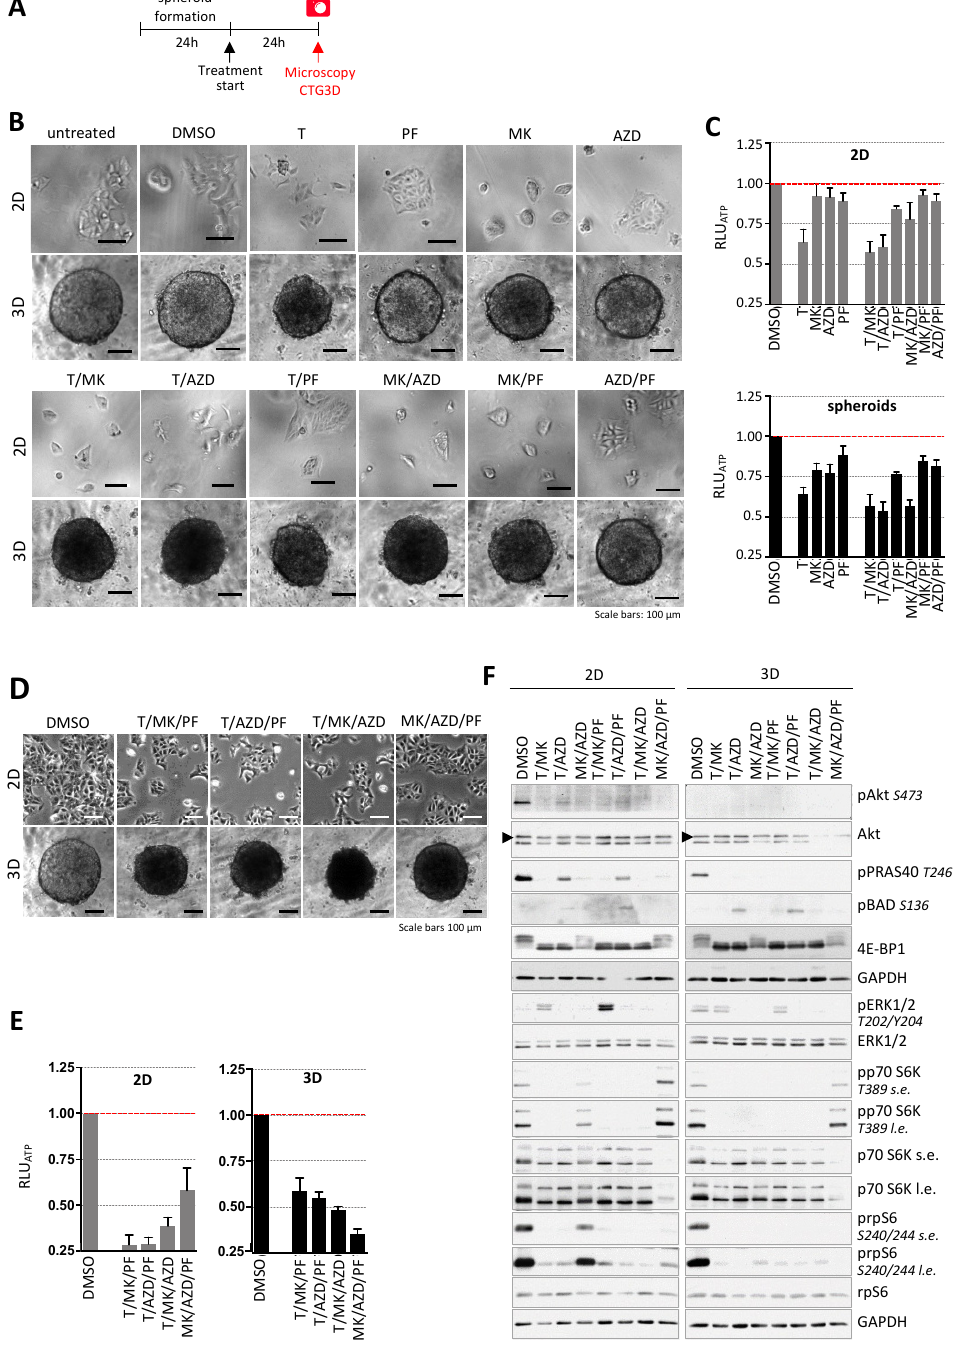
Figure 1. Effect of inhibitor combinations on DLD-1 cells. ( A ) Overview of the time frame of the experiment. ( B ) Representative phase contrast microscopic images of DLD-1 cells in 2D and 3D culture treated with single inhibitors and combinations of Torin1 (T, 250 nM), PF4708671 (PF, 10 µ M), MK2206 (MK, 1 µ M) and AZD6244 (AZD, 1 µ M) for 24 h. Untreated and DMSO cultures are controls. Scale bars represent 100 µ m. ( C ) Cellular ATP levels were determined with CellTiter-Glo 3D. Luminescence values (RLU ATP ) were normalized to the DMSO controls ( n = 6 per condition). Bar graphs are presented as mean ± standard deviation (SD). 2D in gray bars; spheroids in black bars. ( D ) Representative phase contrast microscopic images of DLD-1 cells in 2D and 3D culture upon inhibitor treatment (inhibitor concentrations as in ( B , C ) for 24 h. Scale bars represent 100 µm. ( E ) ATP-levels (RLU ATP from CTG3D) after 24 h treatment were normalized to controls (2D: n = 6 and 3D: n = 9 per condition). Bar graphs are presented as mean ± standard deviation (SD). ( F ) DLD-1 colon cancer cells were treated with a dual and triple inhibitor combinations of T (250 nM), PF (10 µM), MK (1 µM) and AZD (1 µM) for 24 h. DMSO served as control. The impact on the Akt/mTOR and Ras/Raf/MEK/ERK signaling pathways after 24 h was determined by Western blot analysis.